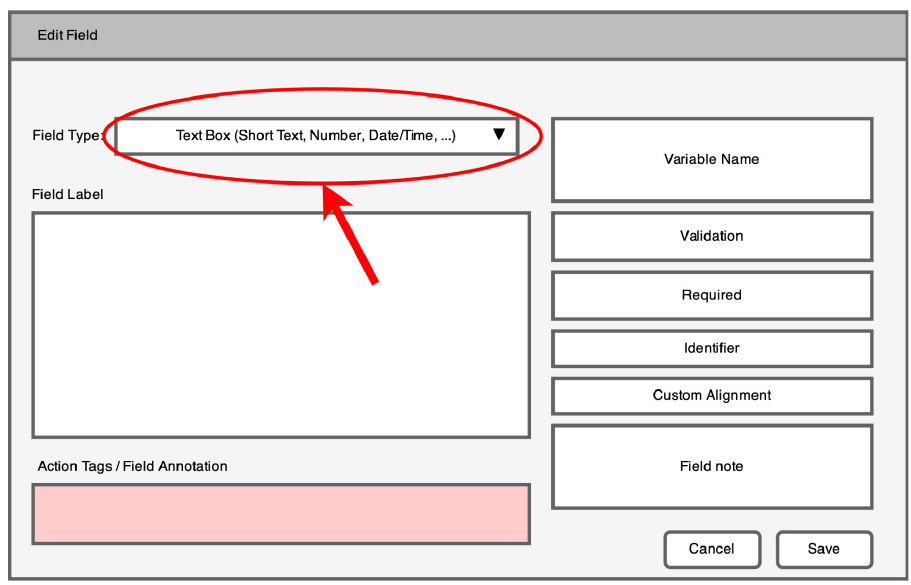
Fig 3. Example of the CBM instrument format required in REDCap for streamlined use with the CHOIRBM package. Selecting a single text box to collect a patient’s body map data allows the CHOIRBM string_to_map() function to automatically generate plot-ready R